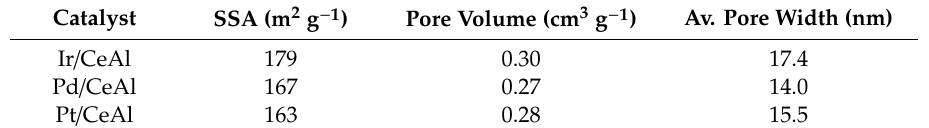
Table 1. Morphological and textural properties for the prepared catalysts.